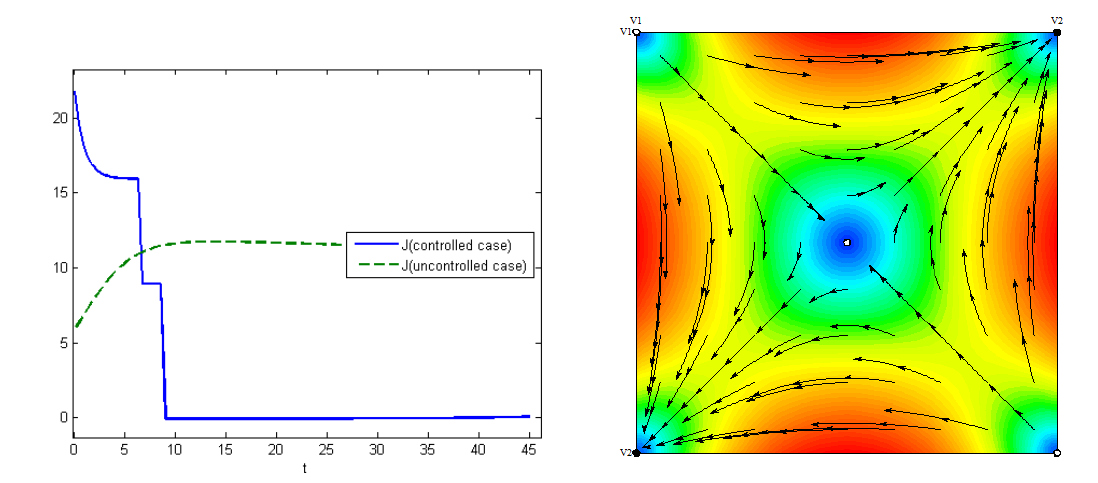
Figure 9. Left : Experiment 4. Comparison of aggregated costs of the SIR model with virus mutation (Controlled model J = 289.42, uncontrolled model J = 1035.4). Vertical axis shows the aggregated costs at time moment t in m.u. Right : Simplex of mixed strategies of the symmetric bimatrix game for modeling virus mutations. In this numerical example, the set of Nash equilibrium was found to be { ( 1,0 ) , ( 0,1 ) , ( 0.5,0.5 ) }